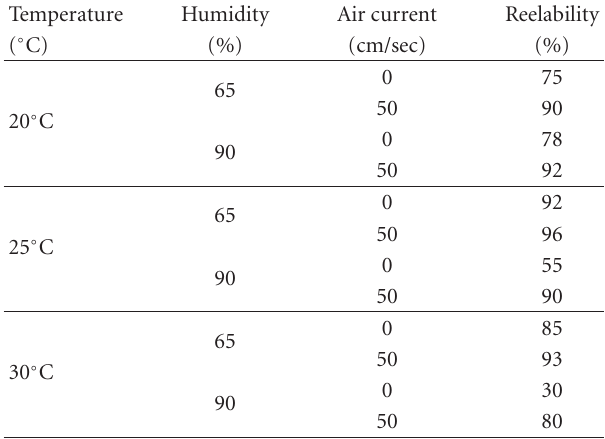
Table 3: Combined e ff ect of humidity and air current during